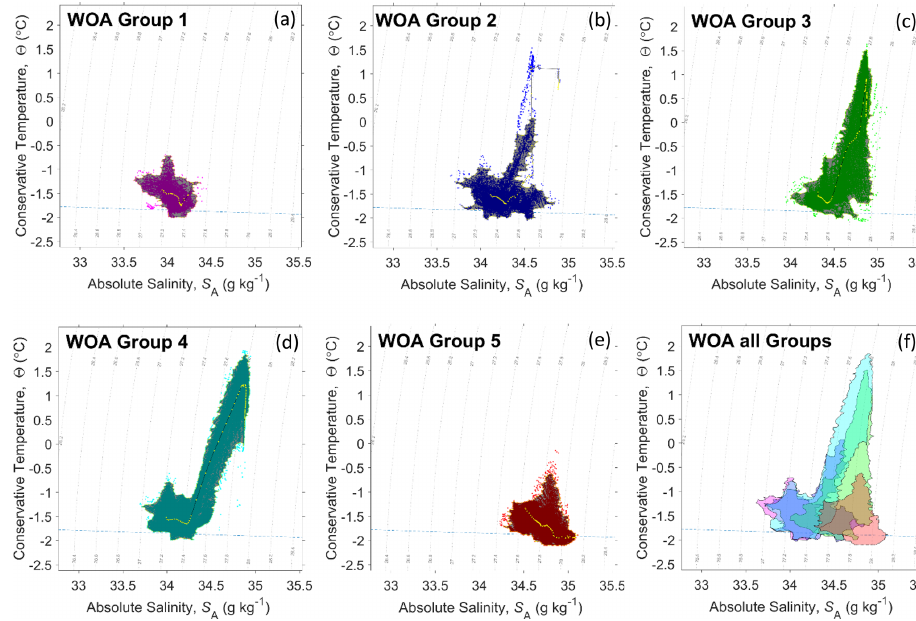
Figure 6. T – S properties for the five WOA groups (from a to e ) shown in Fig. 3e. The dotted yellow lines show the profile of mean temperature and salinity in each group, and the dark shaded areas are the cores of water property from the density-based clustering results. The cores of all five groups are overlaid on the same plot in (f) .